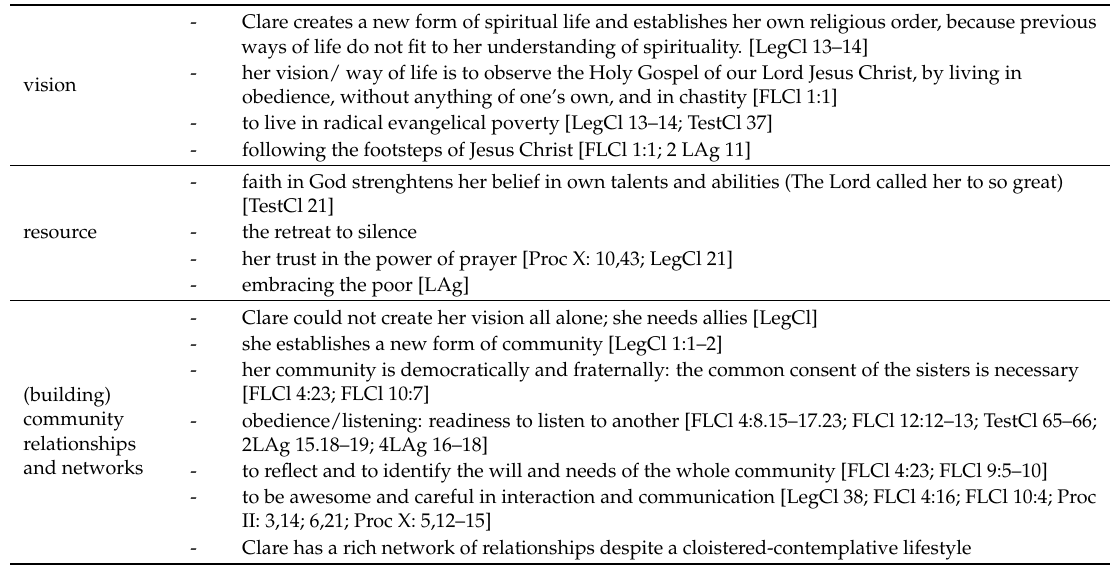
Table 1. Essential components of St. Clare’s leadership